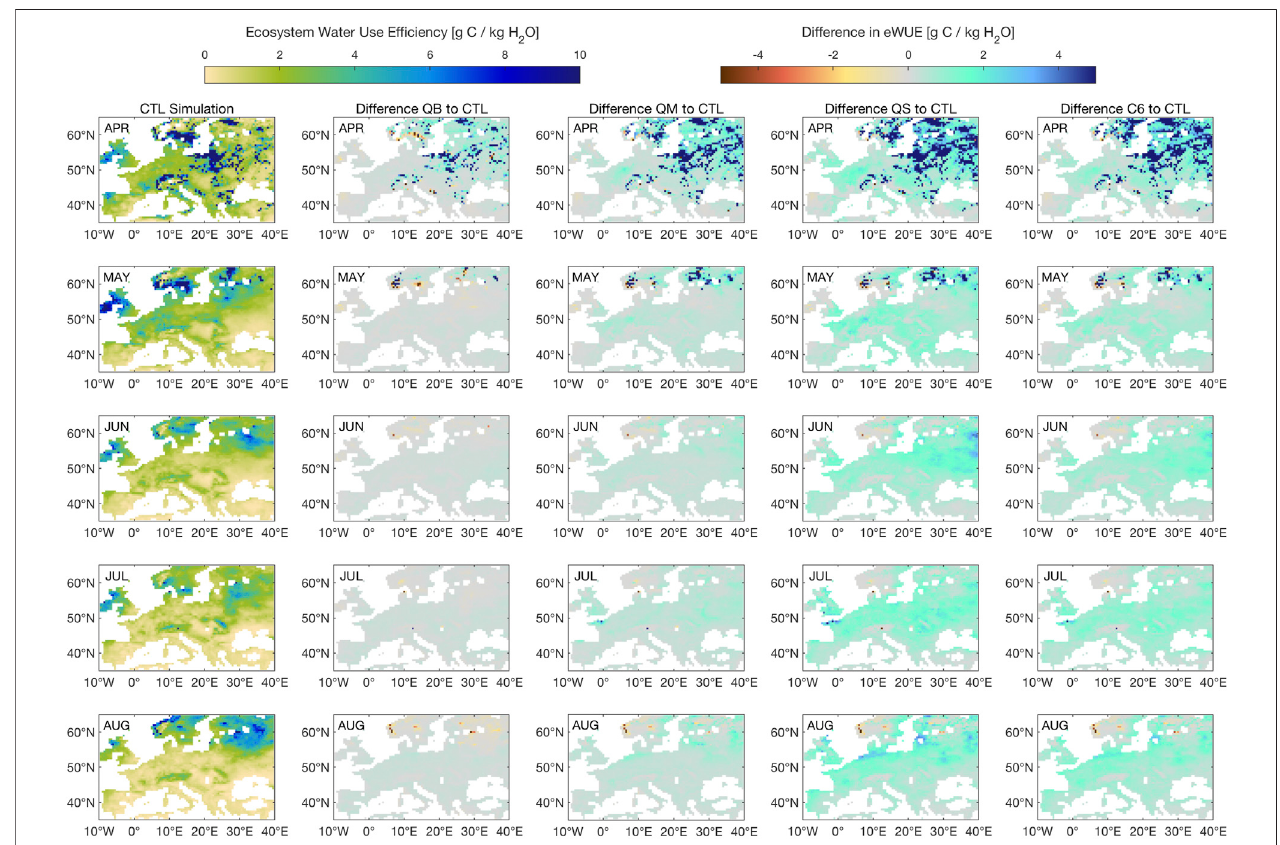
FIGURE 12 | Seasonal evolution of ecosystem Water Use Ef fi ciency (eWUE) for simulation CTL, followed by the difference between each simulation (QB, QS, C6), and CTL. Units are g C per kg of H 2 0.